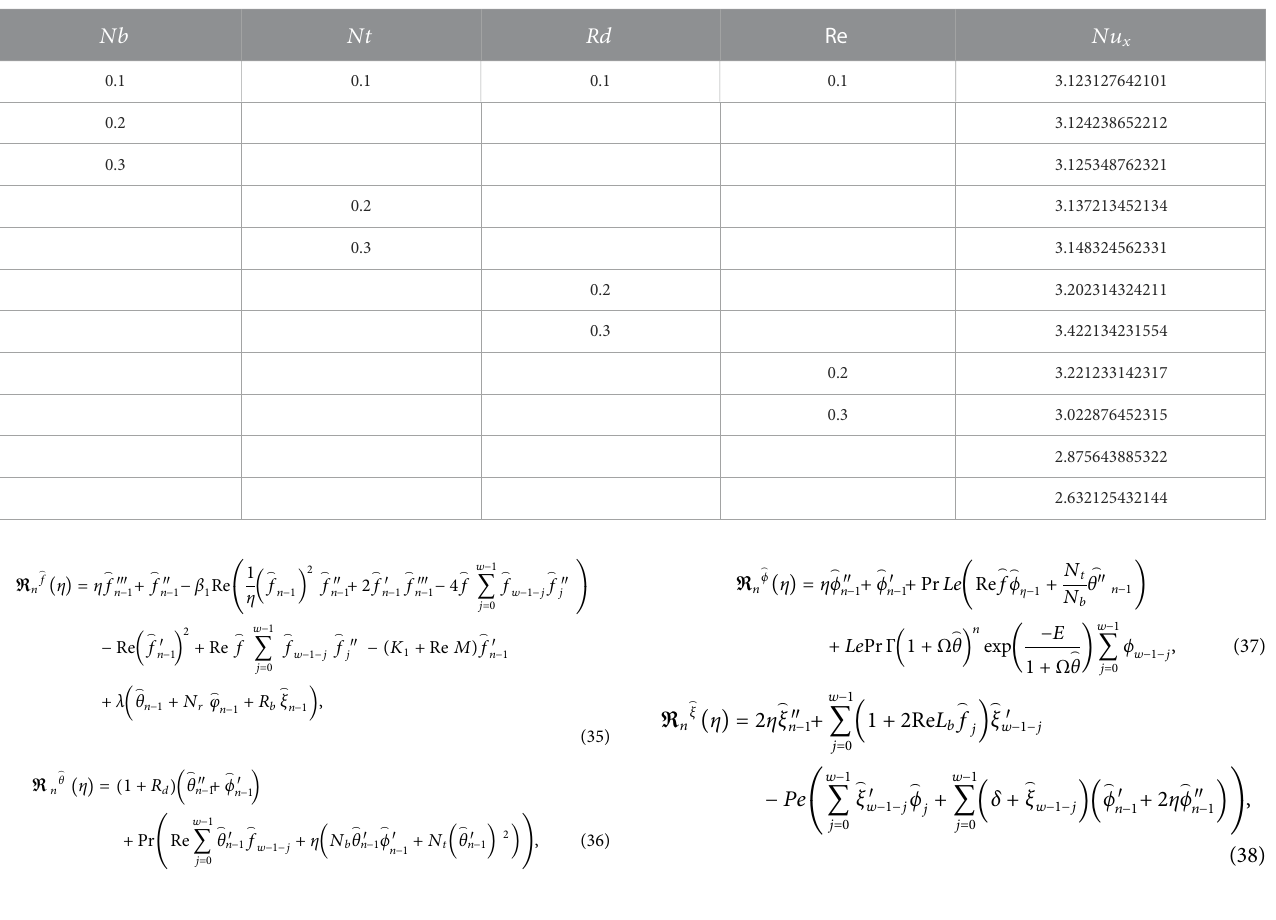
TABLE 3 Nusselt number Nu x Re x − 0 . 5 against numerous